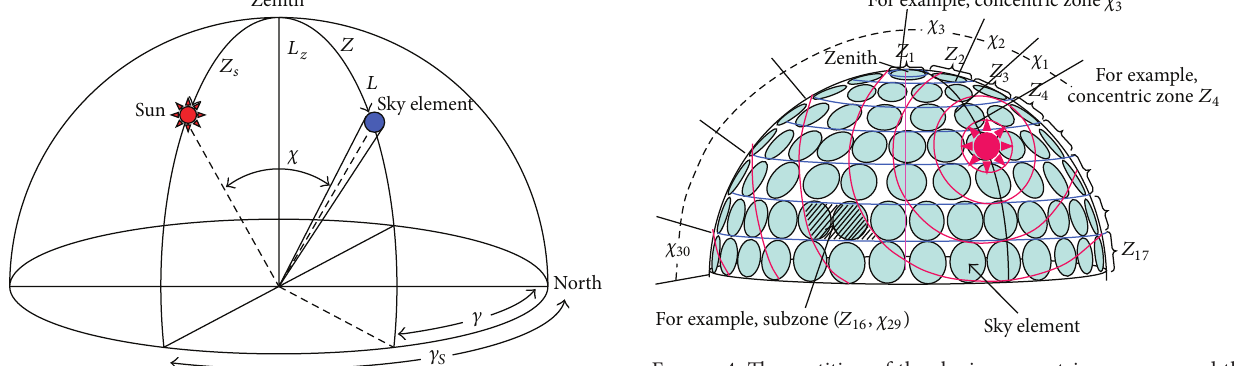
Figure 4: The partition of the sky in concentric zones around the zenith or concentric zones of 𝑍 indicated by 𝑍 𝑖 (𝑖 = 1,...,17) and concentric zones around the sun or concentric zones of 𝜒 indicated by 𝜒 𝑗 (𝑗 = 1,...,30)